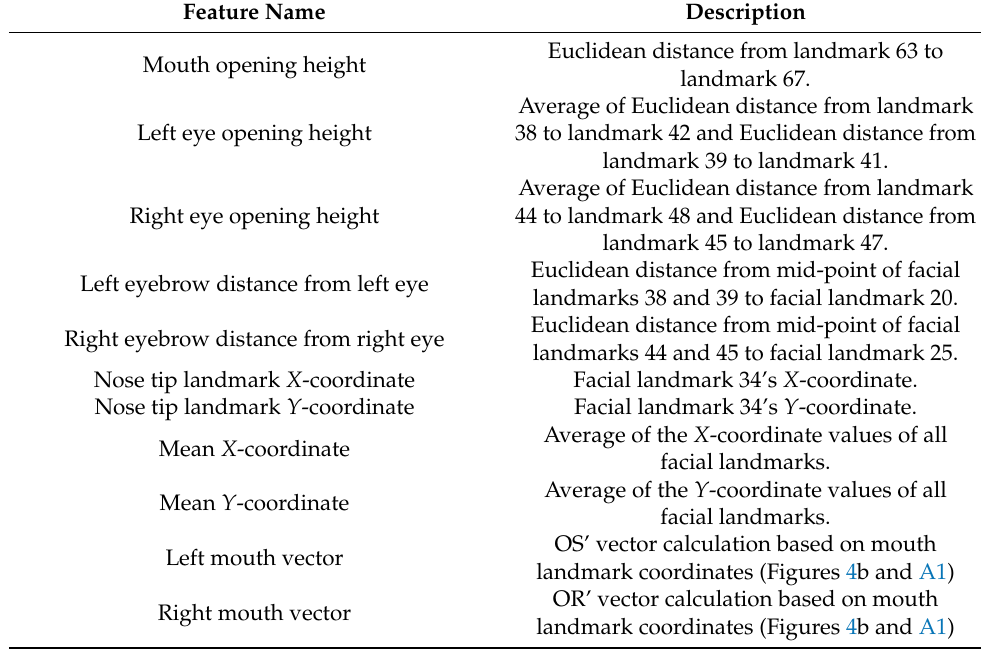
Table 1. Calculated features based on facial